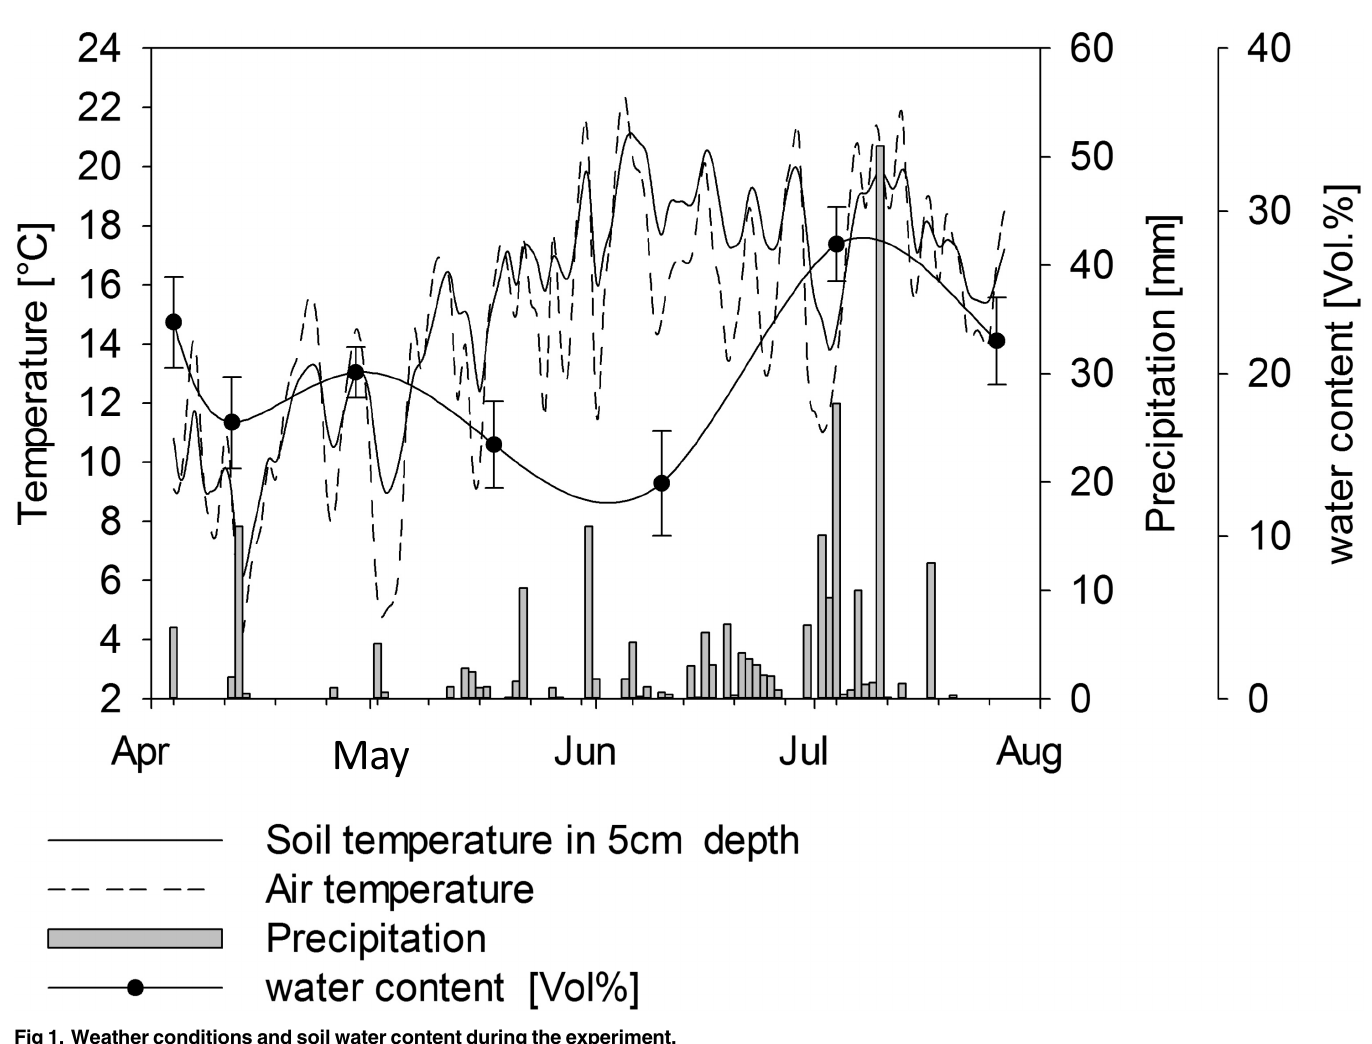
Fig 1. Weather conditions and soil water content during the